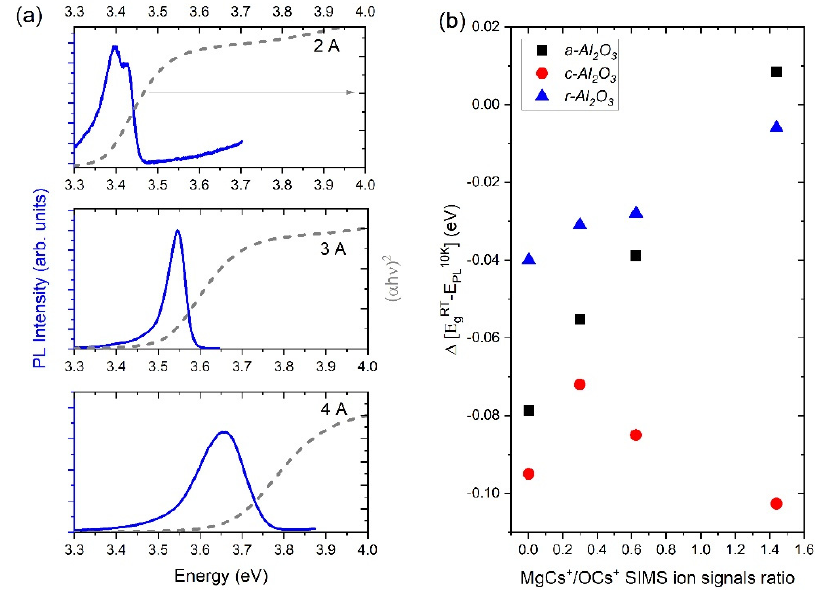
Figure 8. ( a ) PL measured at 10K (blue continuous line) and absorption measured at RT (grey line) extracted from transmittance of the Zn 1 − x Mg x O epitaxial films. ( b ) Delta parameters strictly related to Stokes shift as a function of the MgCs+/OCs+ ion signals measured by